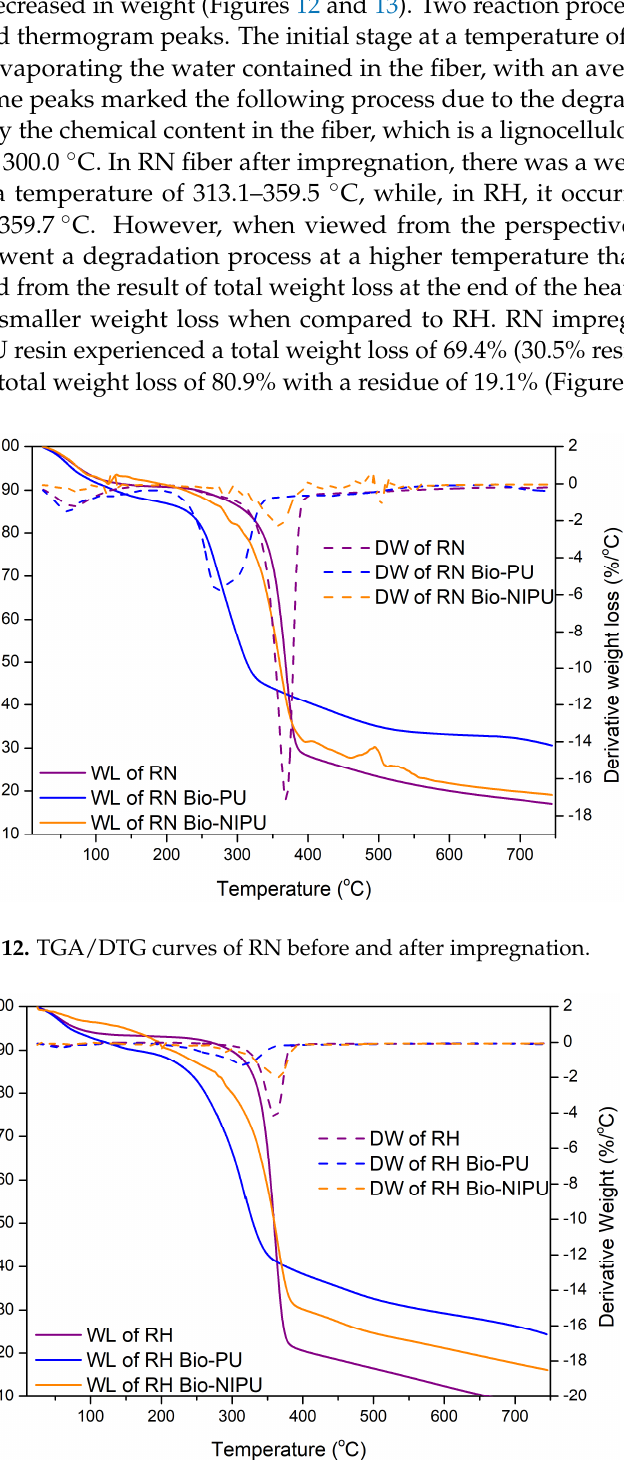
Figure 13. TGA/DTG curves of RH before and after impregnation.